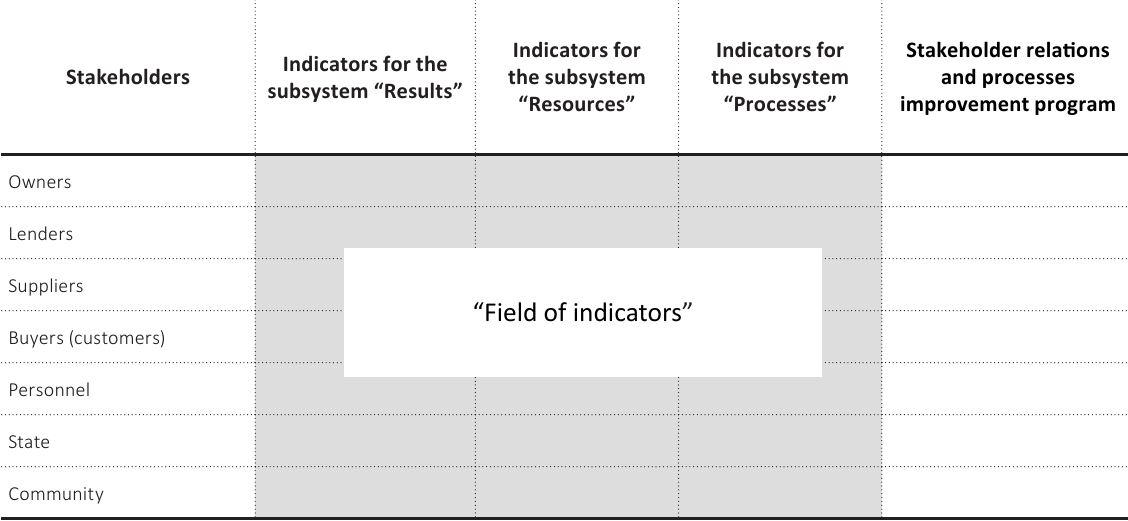
indicators“Field of